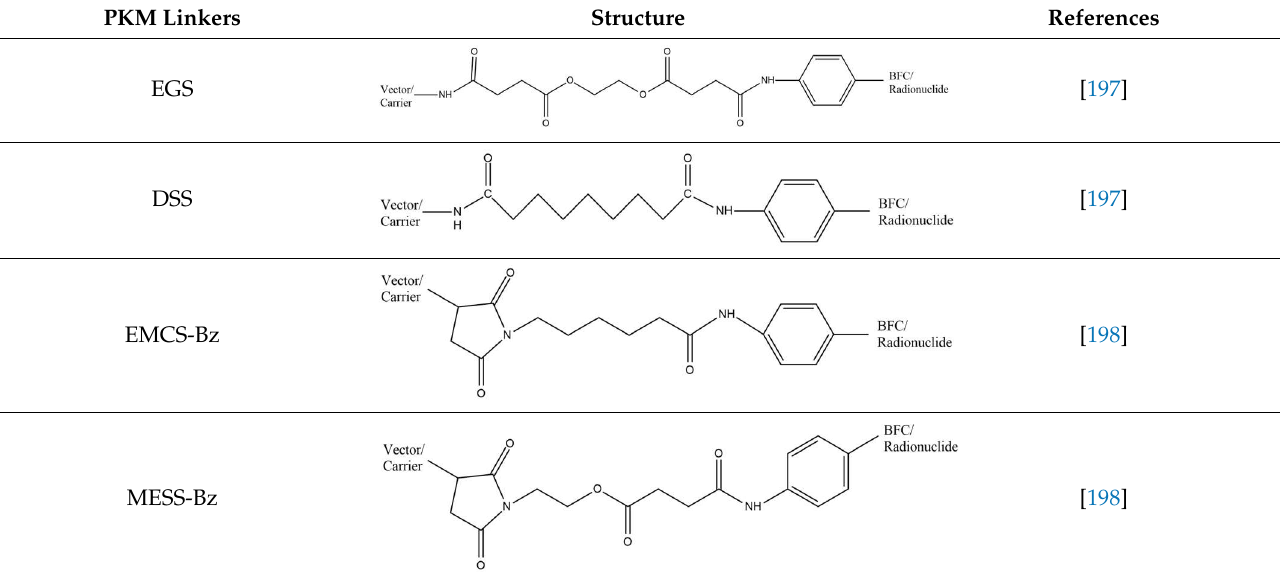
Table 5. Pharmacokinetic-modifying Linkers.